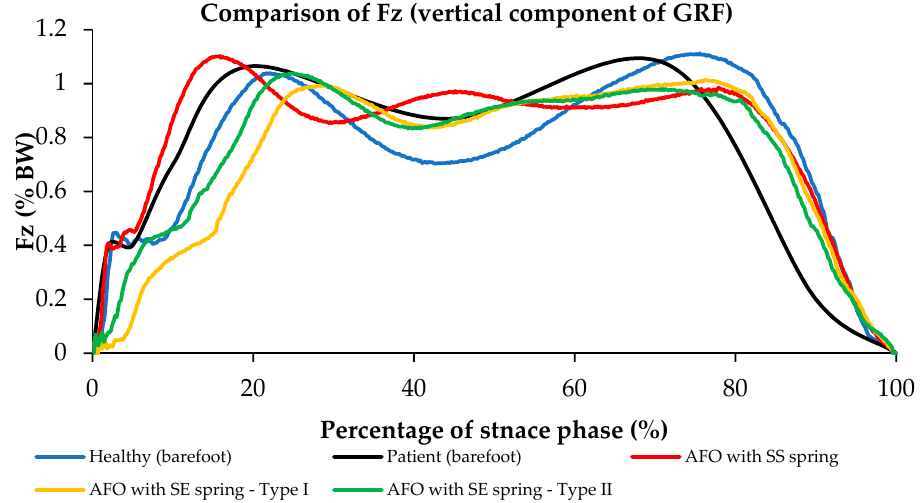
Figure 17. Comparison of Fz (vertical component of GRF) during normal walking using AFO with Stainless Steel spring, AFO with superelastic NiTi spring (0.68 mm), and AFO with superelastic NiTi spring (1.07 mm) (Case ІІ ) [42].